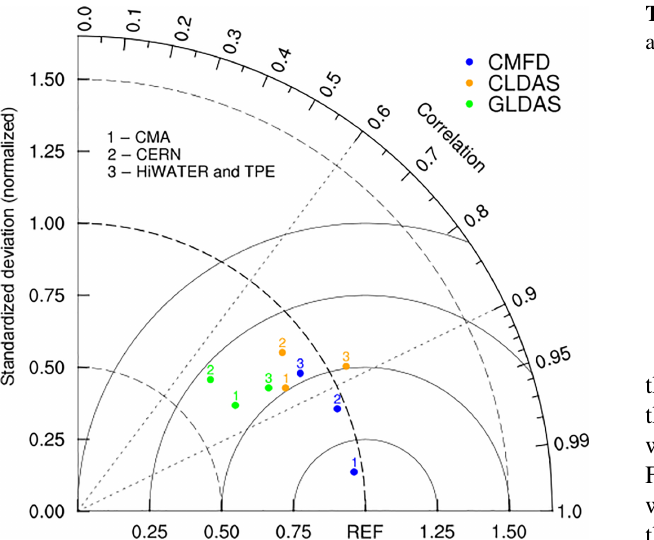
Figure 9. Taylor diagram summarizing the performance of short- wave radiation estimates from CMFD (blue), CLDAS (orange) and GLDAS (green) relative to station observations.